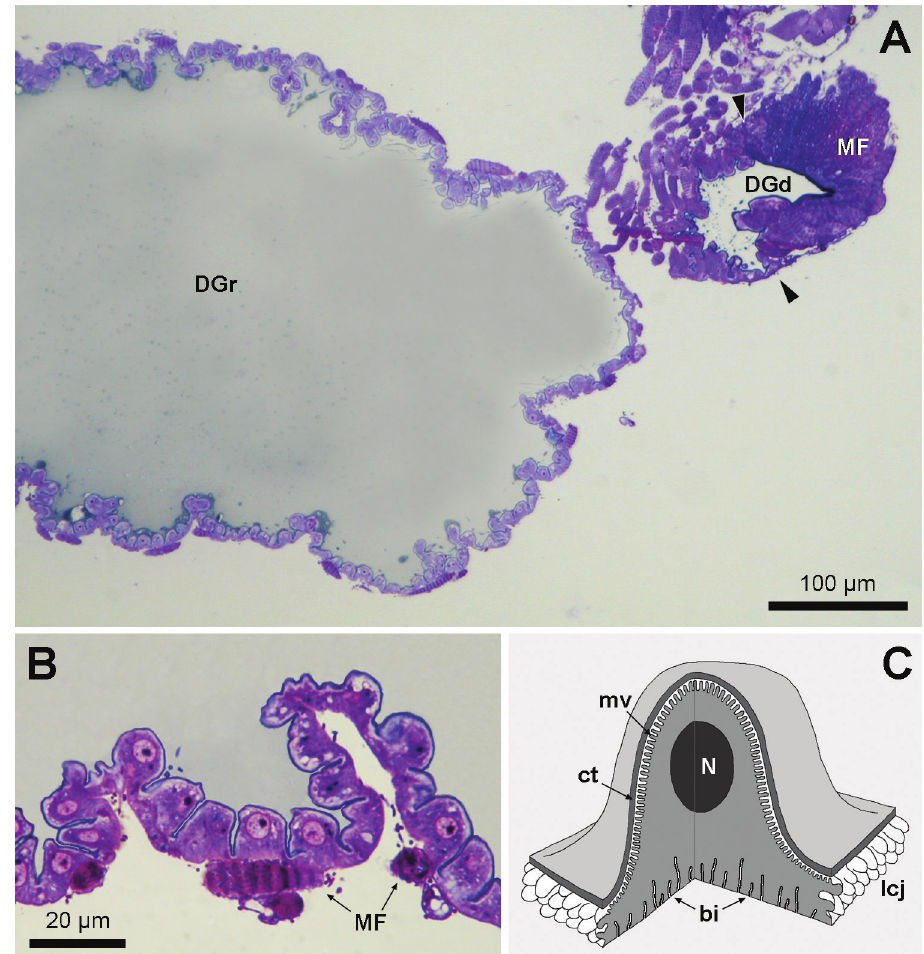
Figure 2. A Semithin section through the Dufour gland reservoir sac (DGr) and duct region (DGd) in Myzinum sp.1. The arrowheads indicate the transition between the reservoir and duct region B Detail of crenellate epithelial lining of reservoir sac with strands of surrounding muscle fibres (MF) C Schematical view of cupola-like shape of gland cell. bi: basal invaginations, ct: cuticle, lcj: lateral cell junction, mv: microvilli, N: